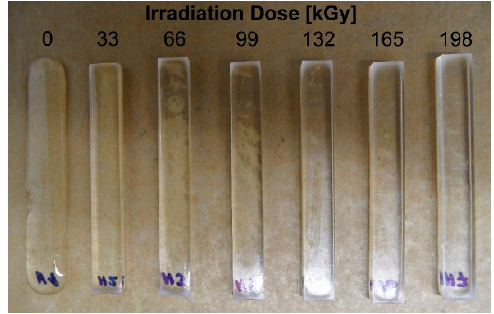
Figure 6. Short-term temperature stability at 220 °C.